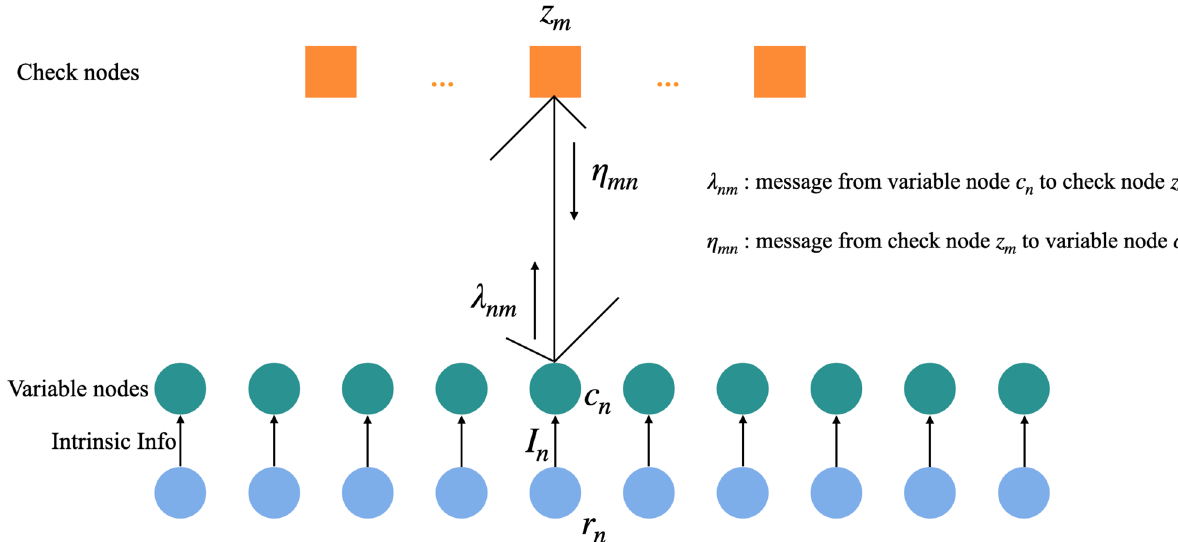
Figure 4. Variable node and check node transfer information mutual. Intrinsic Information is defined I n is the characteristic of channel. For BSC channel, if r n = 0 , I n = log 1 − p I n = log p ( r n | c n = 0 ) p ( r n | c n = 1 ) .